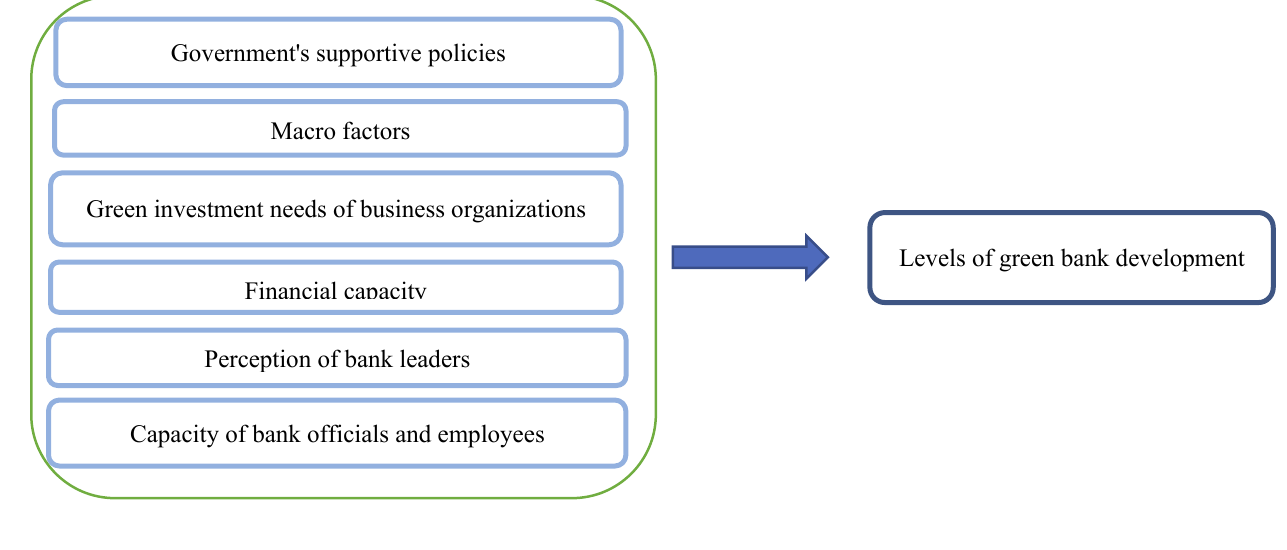
Fig. 1 : Research model